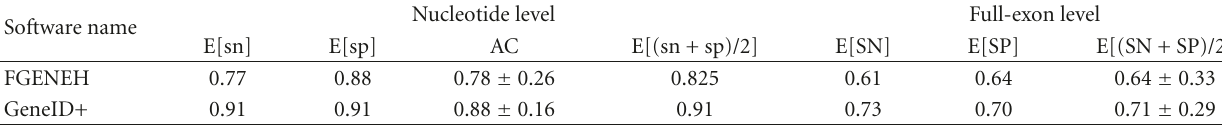
Table 7: Top 2 performers in the evaluation by Burset and Guig´o testing with ALLSEQ.